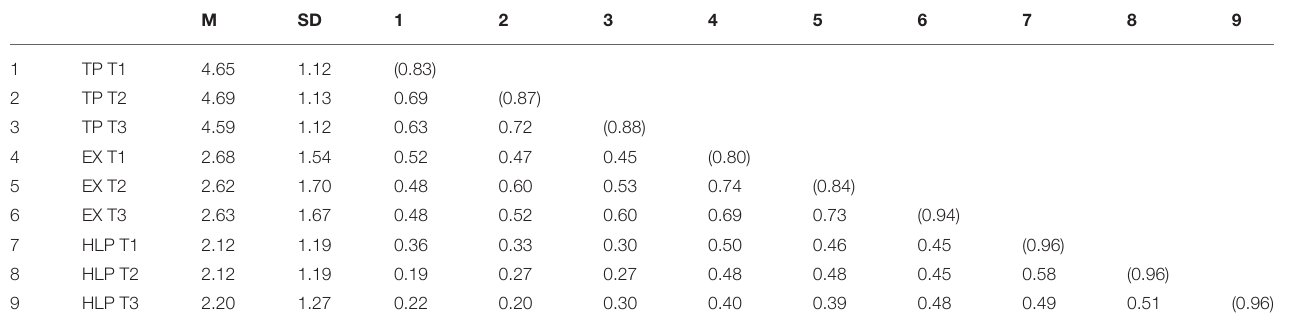
TABLE 2 | Means, standard deviations, correlations and Cronbachs Alpha of the latent variables. M